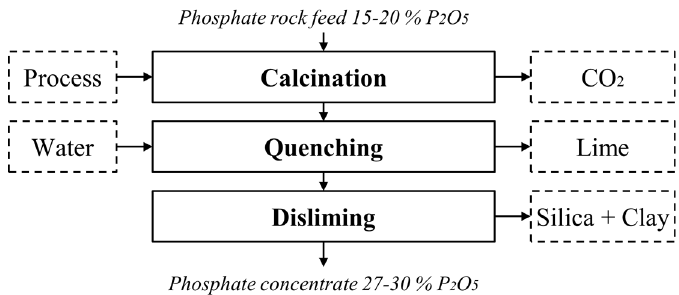
Figure 4. Simplified process flow diagram, describing thermal beneficiation of the Sra Ouertane low-grade phosphate rock by calcination, quenching, and disliming.